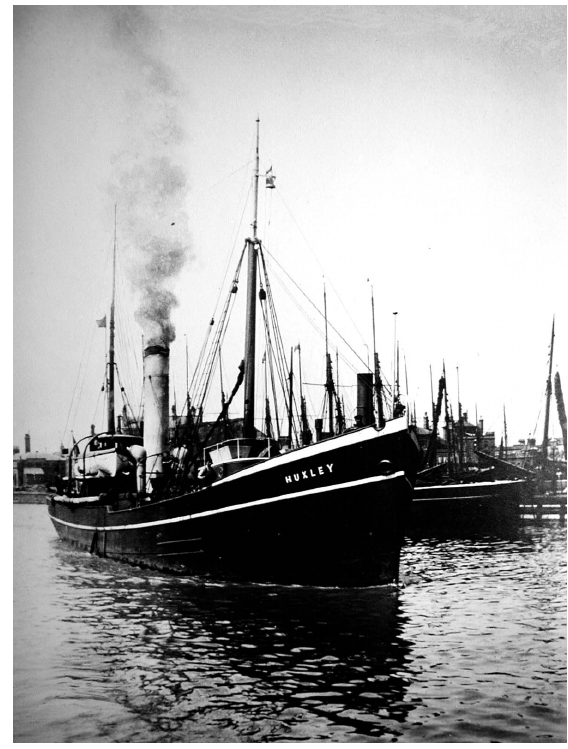
Figure 1. RV Huxley